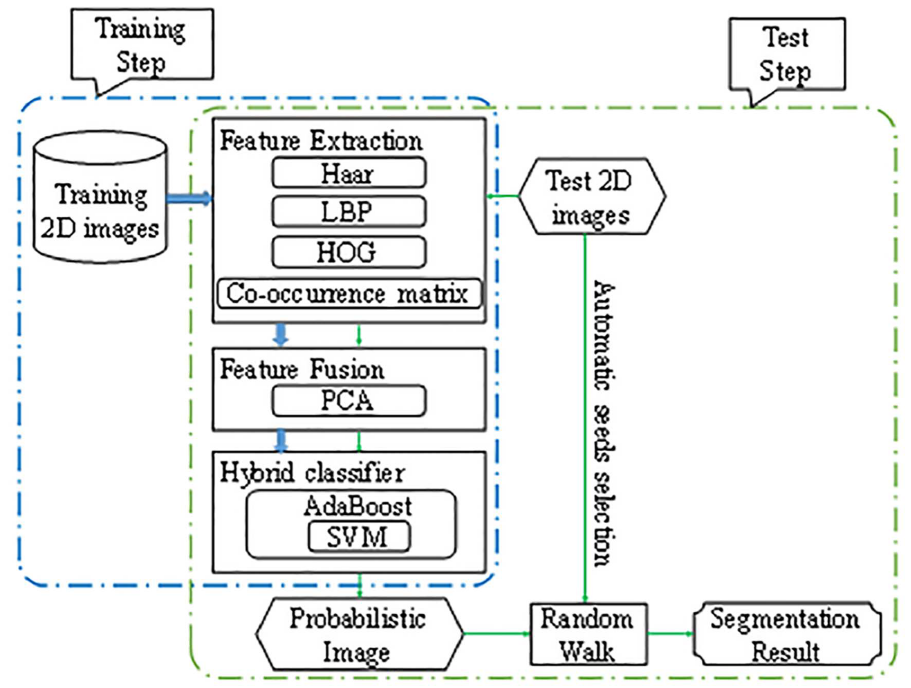
Fig 1. Flowchart of the proposed